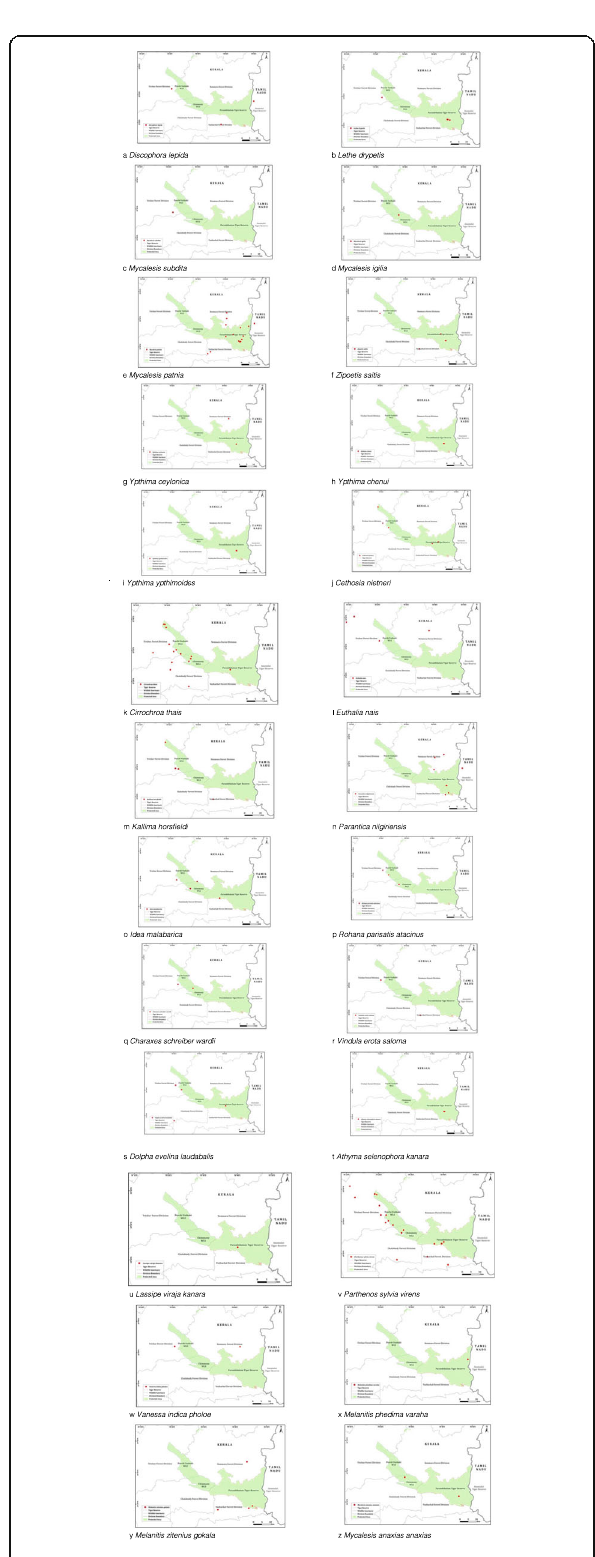
Fig. 5 a - z Distribution maps of endemic butterflies of family Nymphalidae within study area. a Discophora lepida . b Lethe drypetis . c Mycalesis subdita . d Mycalesis igilia . e Mycalesis patnia . f Zipoetis saitis . g Ypthima ceylonica . h Ypthima chenui . i Ypthima ypthimoides . j Cethosia nietneri . k Cirrochroa thais . l Euthalia nais . m Kallima horsfieldi . n Parantica nilgiriensis . o Idea malabarica . p Rohana parisatis atacinus . q Charaxes schreiber wardii . r Vindula erota saloma . s Dolpha evelina laudabalis . t Athyma selenophora kanara . u Lassipe viraja kanara . v Parthenos sylvia virens . w Vanessa indica pholoe . x Melanitis phedima varaha . y Melanitis zitenius gokala . z Mycalesis anaxias